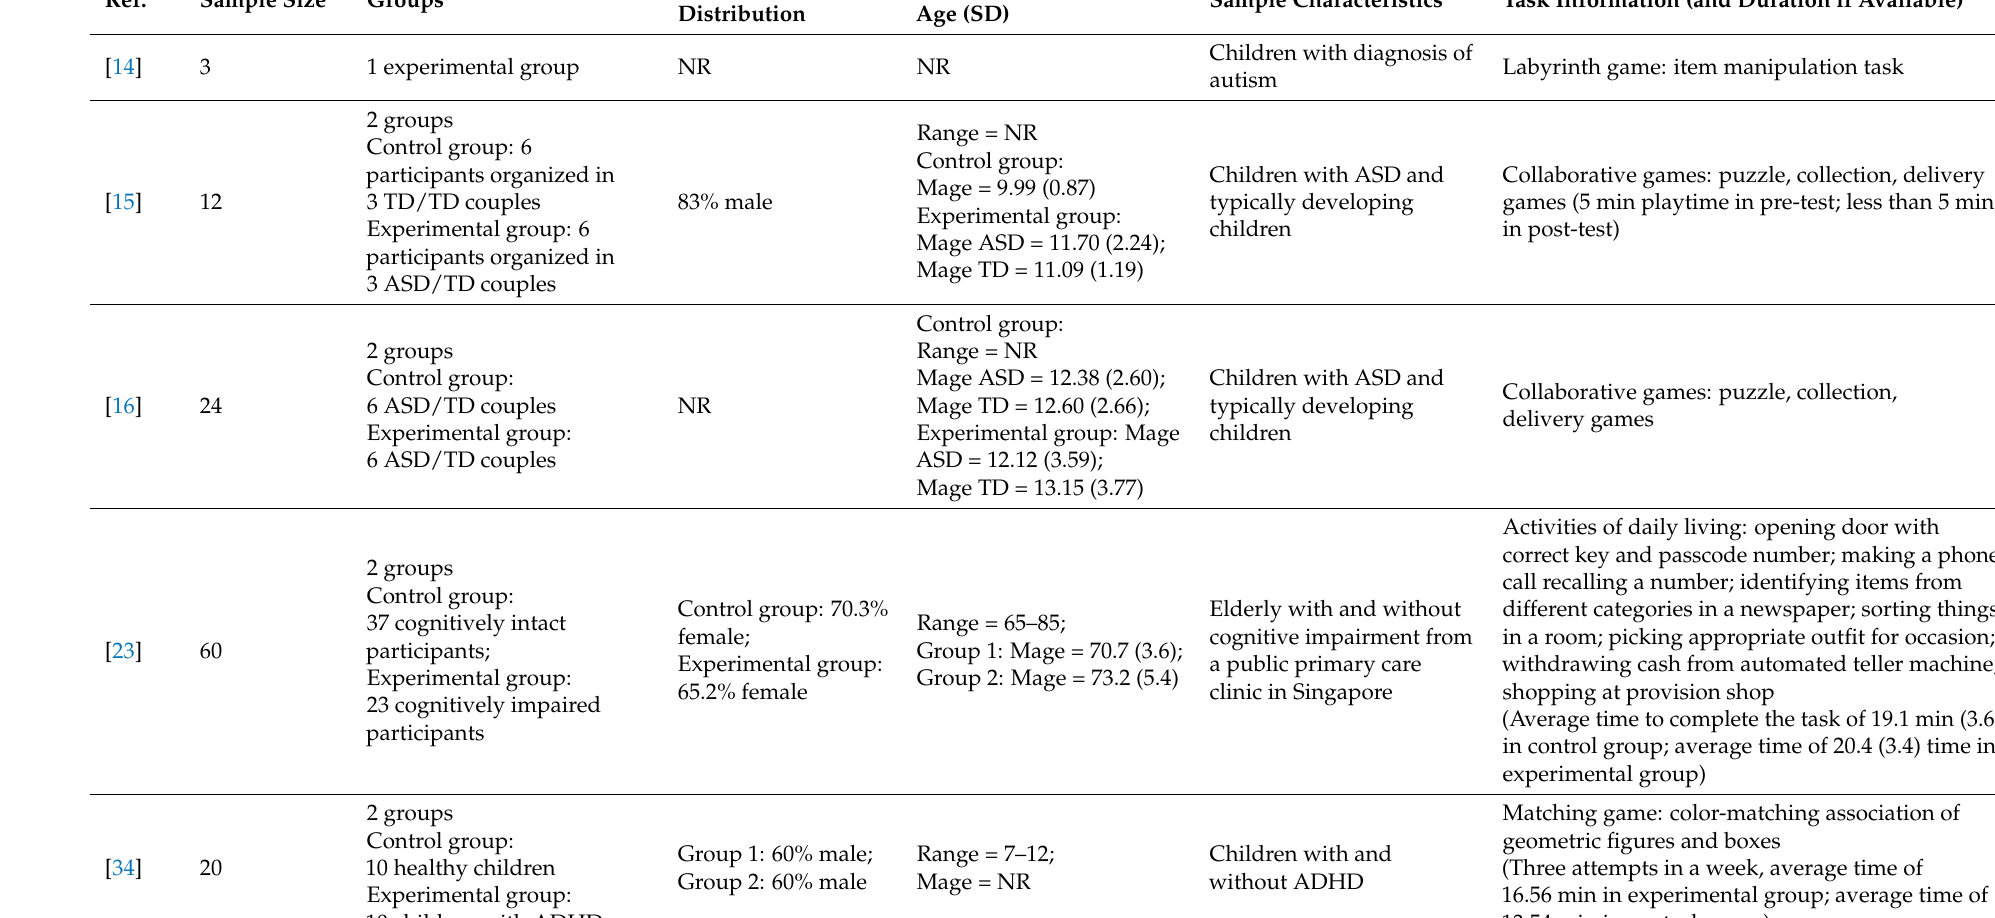
Table A1. Main characteristics of the studies reviewed: authors, sample size, gender distribution, age range, mean age, sample characteristics, and task information ( n = 19).